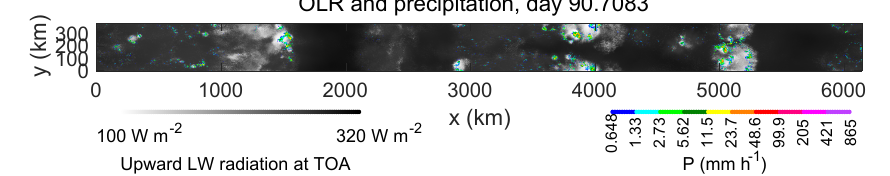
Figure 4. Hourly-average outgoing longwave radiation (gray shading) and precipitation (color shading) in large-domain SAM simulation at T s = 300K.